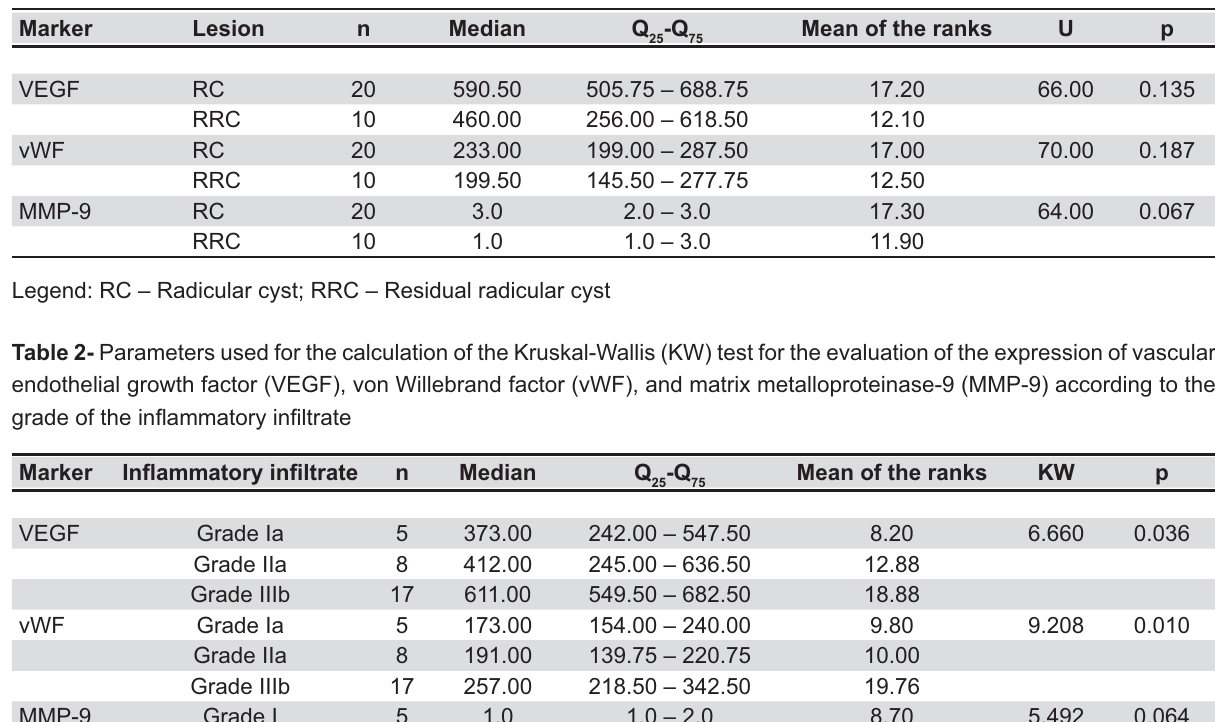
Table 1- Parameters used for the calculation of the Mann-Whitney U test for the evaluation of the expression of vascular endothelial growth factor (VEGF), von Willebrand factor (vWF), and matrix metalloproteinase-9 (MMP-9) according to the type of lesion